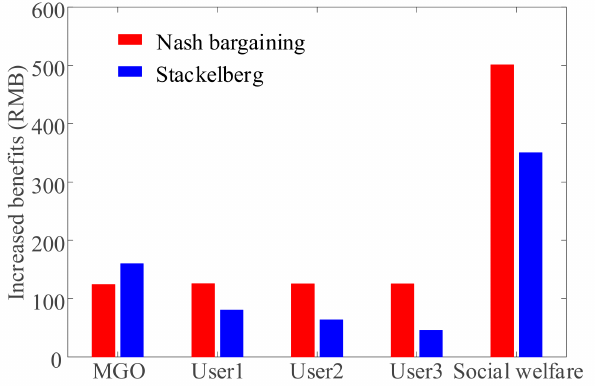
Figure 10. Comparison of increased economic